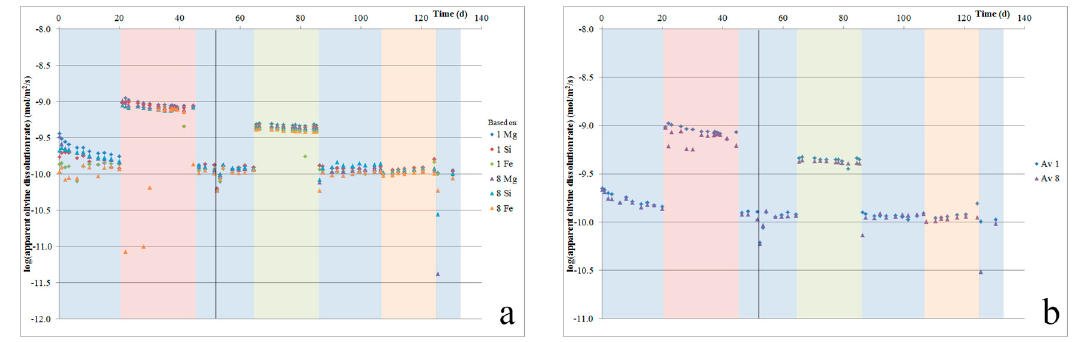
Figure 6. Apparent mineral dissolution rates for olivine in Åheim dunite. Graph ( a ) shows the rates calculated per individual element released, while ( b ) shows the averaged rates per sample. Note the slight decrease in dissolution rate during the first ~30 days, after which the rate stabilized.